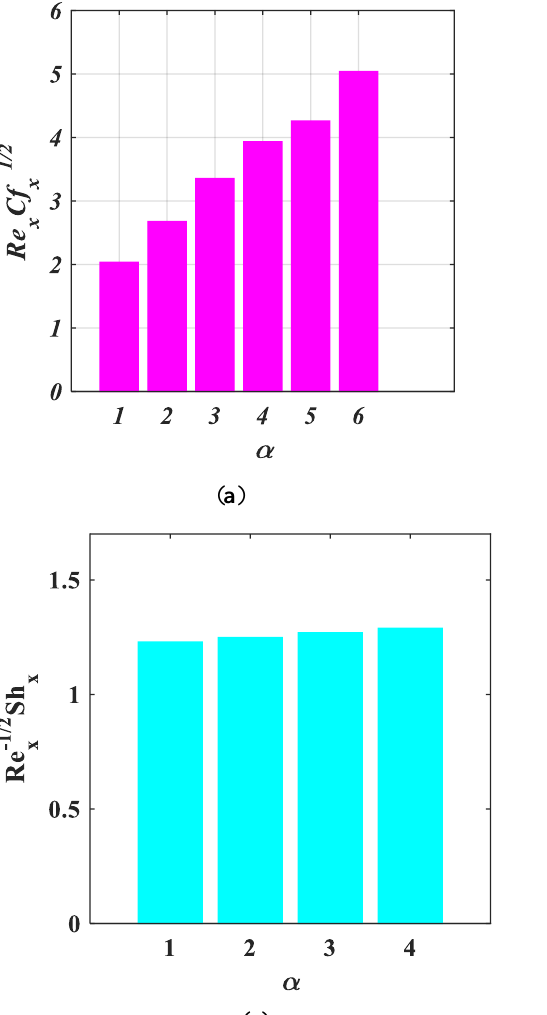
, 𝑅𝑒 𝑥−1/2 𝑁𝑢 , 𝑅𝑒 𝑥−1/2 𝑆ℎ , 𝑅𝑒 𝑥−1/2 𝑁ℎ 𝑥 𝑥 𝑥 against 𝑥